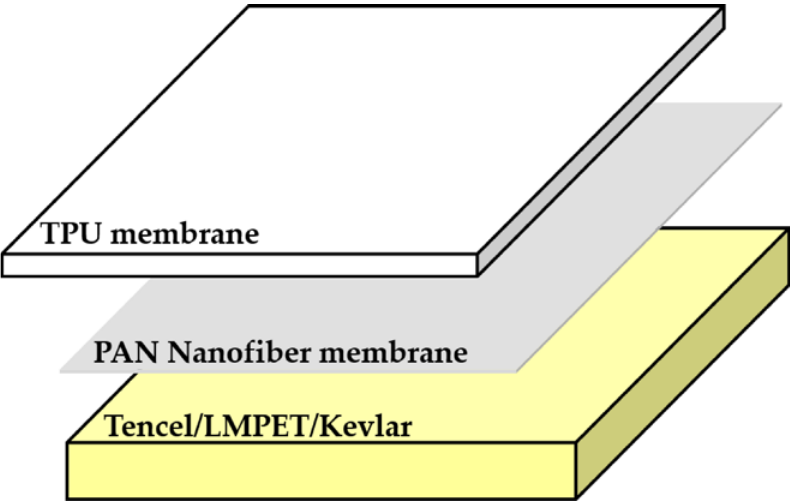
Figure 1. Diagram of the composition of lay-up compound